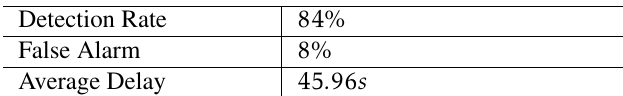
Table 3. Off-line Simulation Result